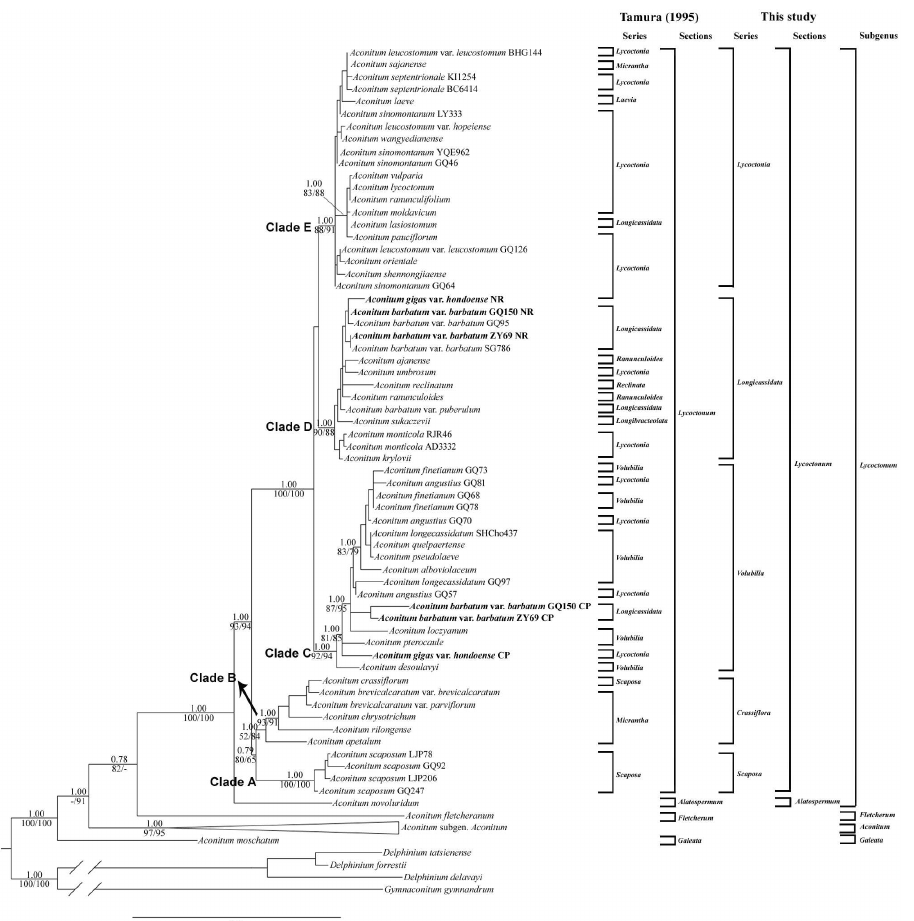
Fig 3. Phylogenetic relationships in Aconitum obtained from an ML analysis of the combined cpDNA and nrDNA dataset. Numbers above branches are posterior probabilities; numbers belowbranchesare bootstrapvalues for maximum parsimony/maximum likelihoodanalyses. “-” indicates that support is less than 50% bootstrapvalue. Tamura’s (1995) classification and our new classificationof subgen. Lycoctonum are shown on the right. Accessions with different placements betweenthe cpDNA tree and the nrDNA tree are indicatedin bold. The clade of subgen. Aconitum has been collapsedfor saving space (see S3 Fig for the